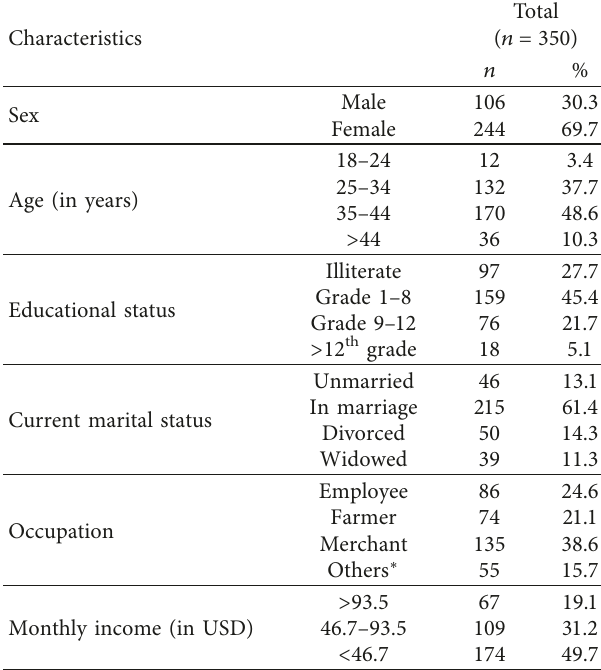
Table 1: Sociodemographic characteristics of participants at Hiwot Fana Specialized University Hospital, Eastern Ethiopia, 2016.